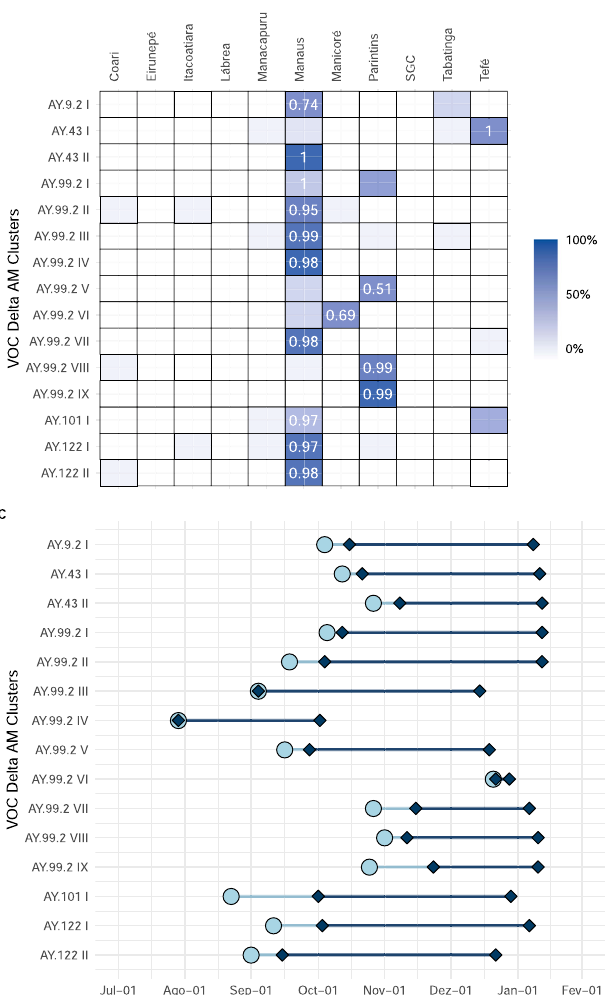
and Omicron genomic clusters. Median T MRCA (circles) and dates of fi rst and last sampling times (diamonds) are plotted on the X axis and genomic cluster on the Y axis. Light color lines correspond to detection lag (i.e., the difference between the T MRCA and the date at which a transmission lineage was detected) and dark color lines correspond to the full sampling range of each transmission